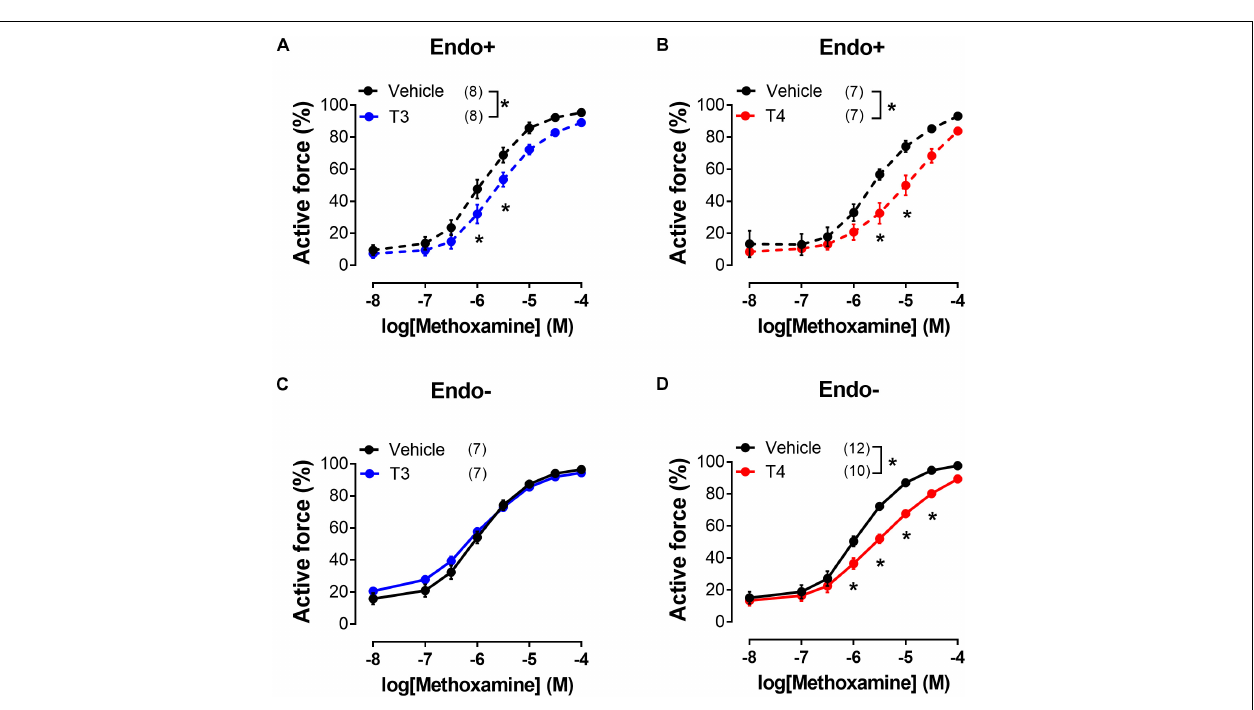
FIGURE 2 | T3 and T4 weaken contractile responses of sural arteries to methoxamine via endothelium-dependent and endothelium-independent mechanisms, respectively. Concentration-response relationships of endothelium-intact (Endo+) (A,B) and endothelium-denuded (Endo-) (C,D) arteries to methoxamine in the presence of vehicle or T3 (A,C) or T4 (B,D) . Number in parentheses represents the number of animals. * p < 0.05 compared to vehicle group (Repeated Measures ANOVA with Tukey’s post hoc